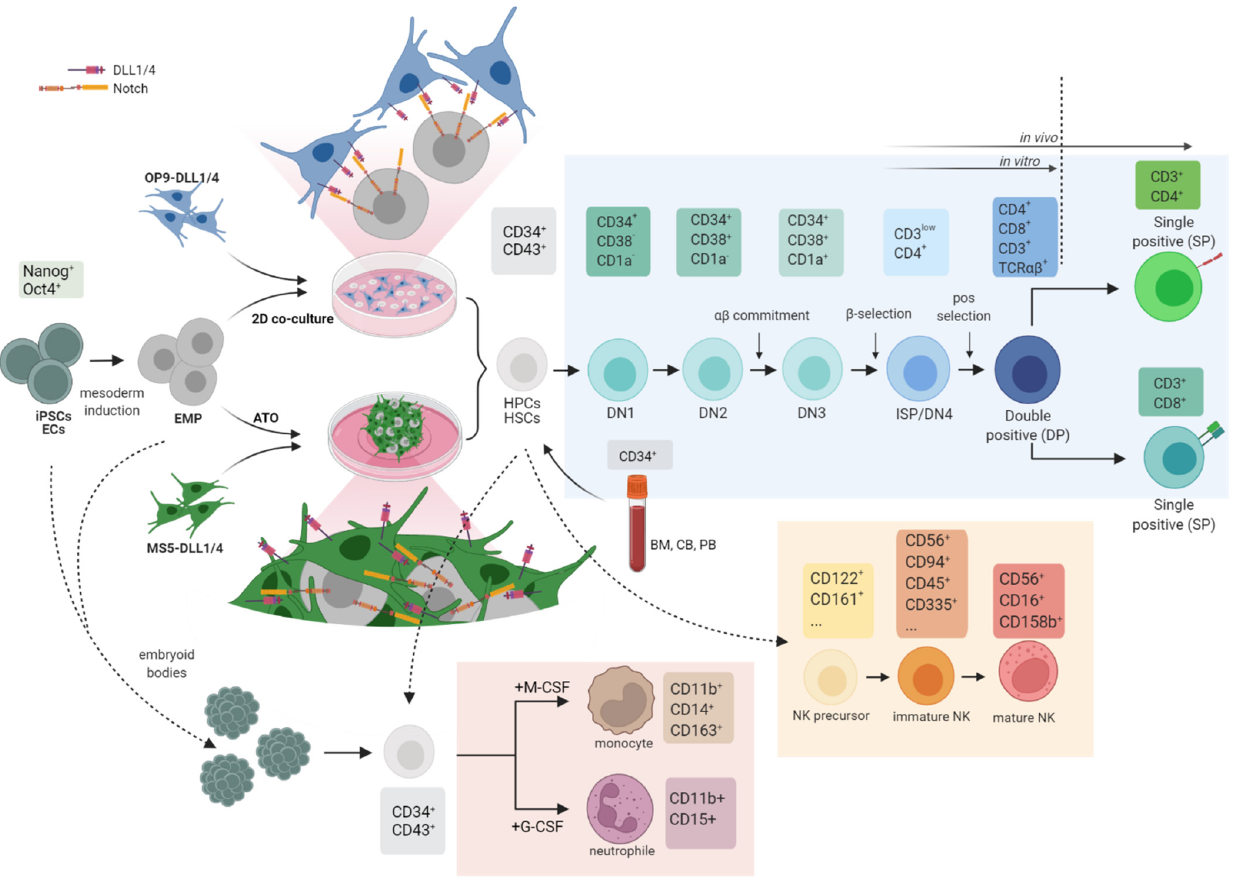
Figure 2. Overview of the current strategies used in IEI in vitro models to generate lineage-committed hematopoietic cells. So far, IEI in vitro models have focused on T-cell, NK-cell, monocyte and granulocyte (i.e., neutrophil) differentiations. T-cell differentiation can be performed in 2-dimension via the co-culture of mouse stromal cells (OP9) expressing delta-like ligands (DLL1 or DLL4) to stimulate Notch signaling on CD34 + cells. T cells can be differentiated in a 3-dimensional system via the use of artificial thymus organoids (ATO), where mouse stroma cells (MS5) expressing DLL1 or DLL4 are mixed with CD34 + cells. Generating NK cells in vitro is controversial; NK cells can be obtained via the OP9-DLL1/4 or ATO system but verification of their development via surface markers is currently challenging [135]. Generation of innate cells such as monocytes and neutrophils is usually performed via the formation of embryoid bodies which are induced towards mesoderm and subsequent hematopoietic progenitor cells; M-CSF and G-CSF are allowing the conversion towards one or the other lineage. CD34 + cells can be obtained from BM, UCB, PB as an adult stem cell source or via the differentiation of iPSCs or ESCs. BM: bone marrow, UCB: umbilical cord blood, PB: peripheral blood, EC: endothelial cell, EMP: erythroid-myeloid progenitor. Created with